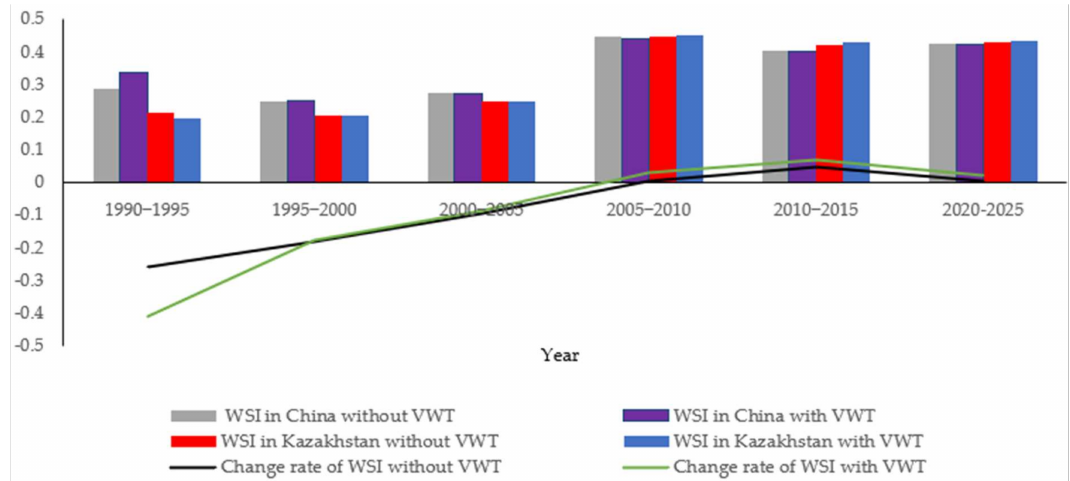
Figure 7. Change rate of WSI in the study area under both